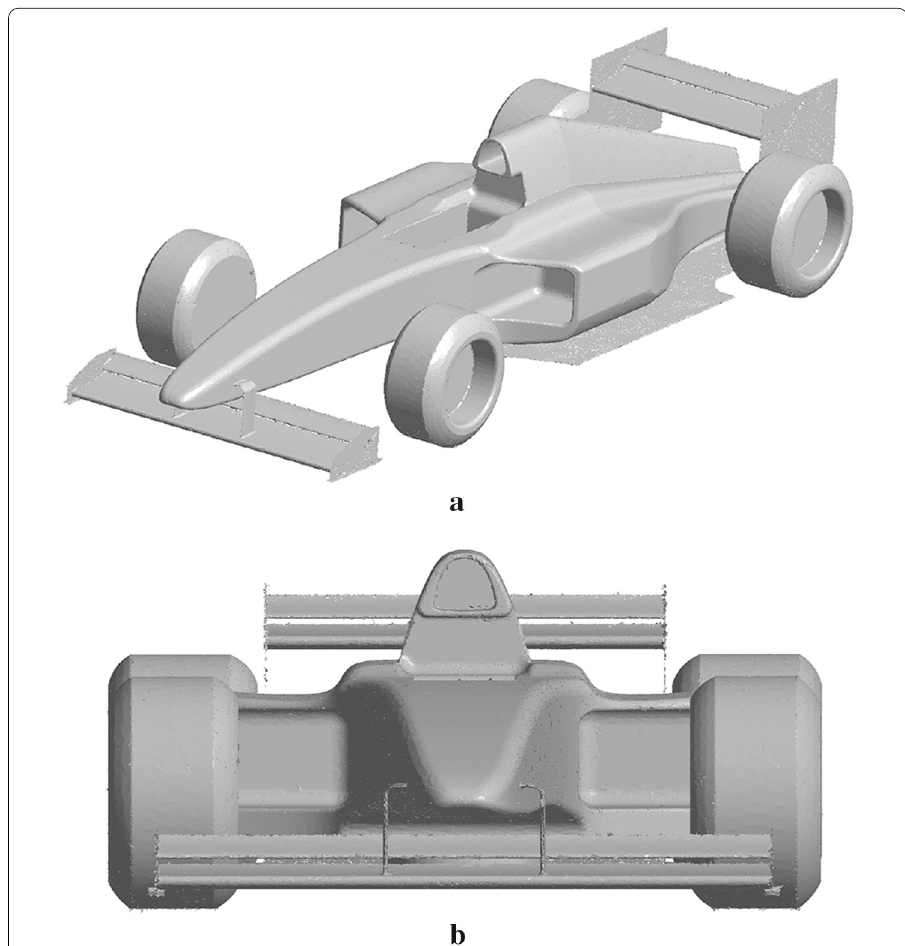
Fig. 40 Surface approximation of racing car after massive refinement of background mesh (9 e 6 elements). a Iso-view. b